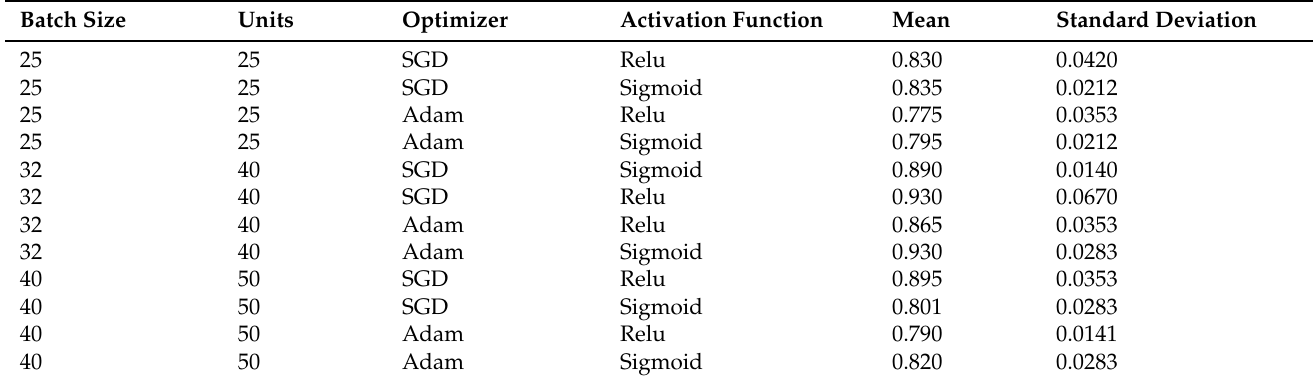
Table 2. Neural network parameters.